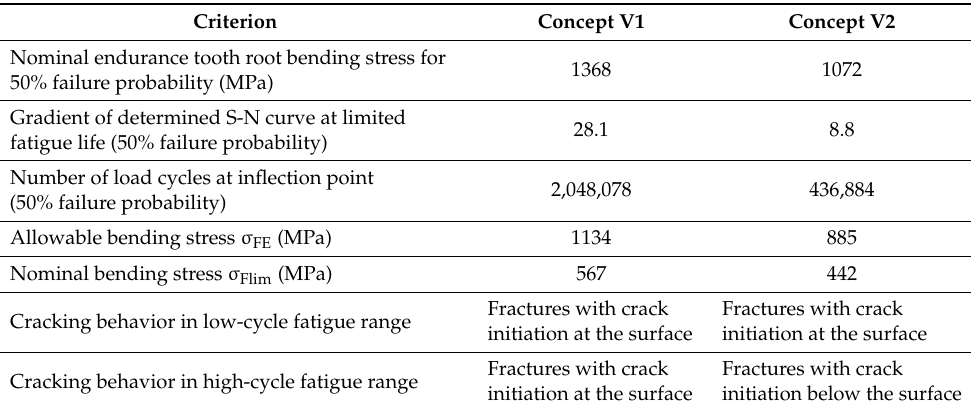
Figure 14. Comparison of the tooth root bending stress numbers of newly developed case carburized steels: ( a ) vs. strength levels of DIN 3990 and vs. the results of reference steels determined under comparable test conditions [30]; ( b ) vs. selected alternative case carburizing steels as specified in Table 1. Table 5. Characteristics of the determined S-N-curves concerning tooth root bending strength for 50% failure probability, as well as nominal and allowable bending stress